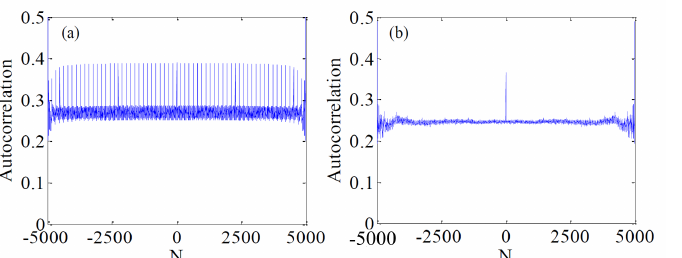
Figure 11. Autocorrelation comparison based on different logistic maps. ( a ) The original logistic map; ( b ) The enhanced logistic map.